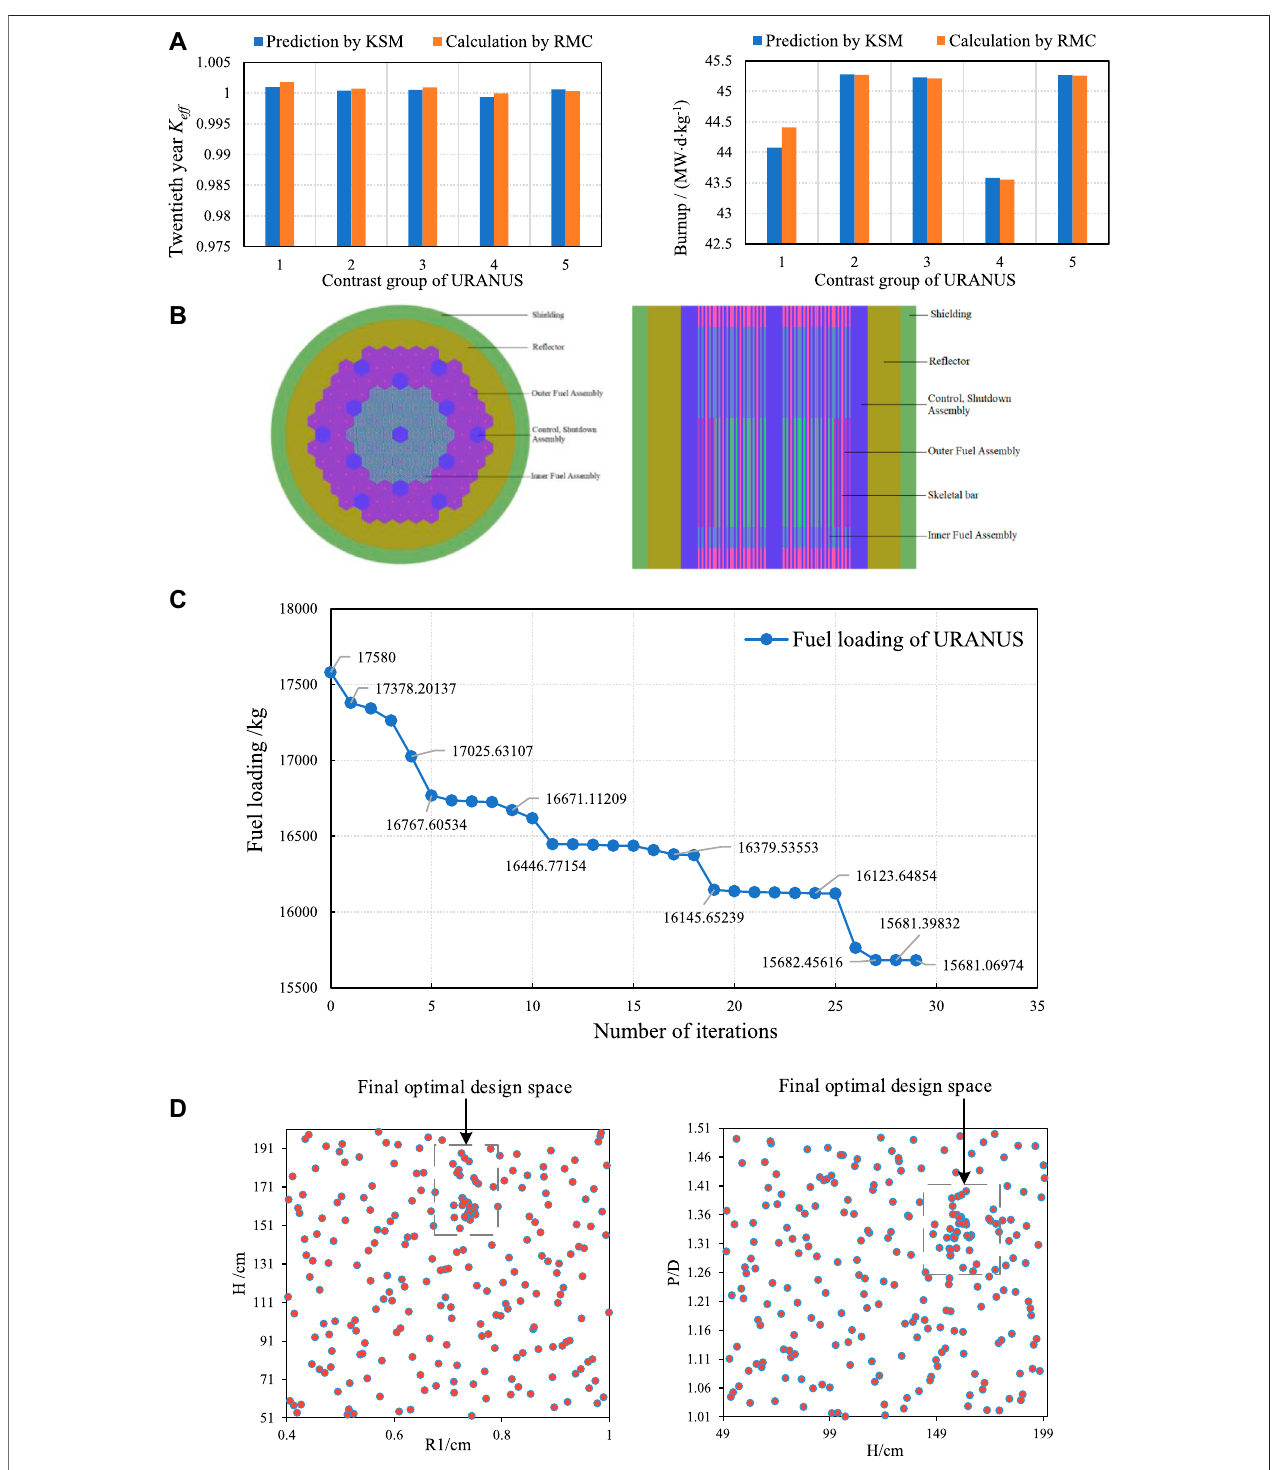
FIGURE6| Optimizationveri fi cationresultsofURANUS. (A) Comparisonof K eff andburnupobtainedusingKSMandRMCcode, (B) CorestructureofURANUSfor optimization veri fi cation, (C). Iterative graph of fuel loading optimization for URANUS, (D) Final optimal design space for URANUS.